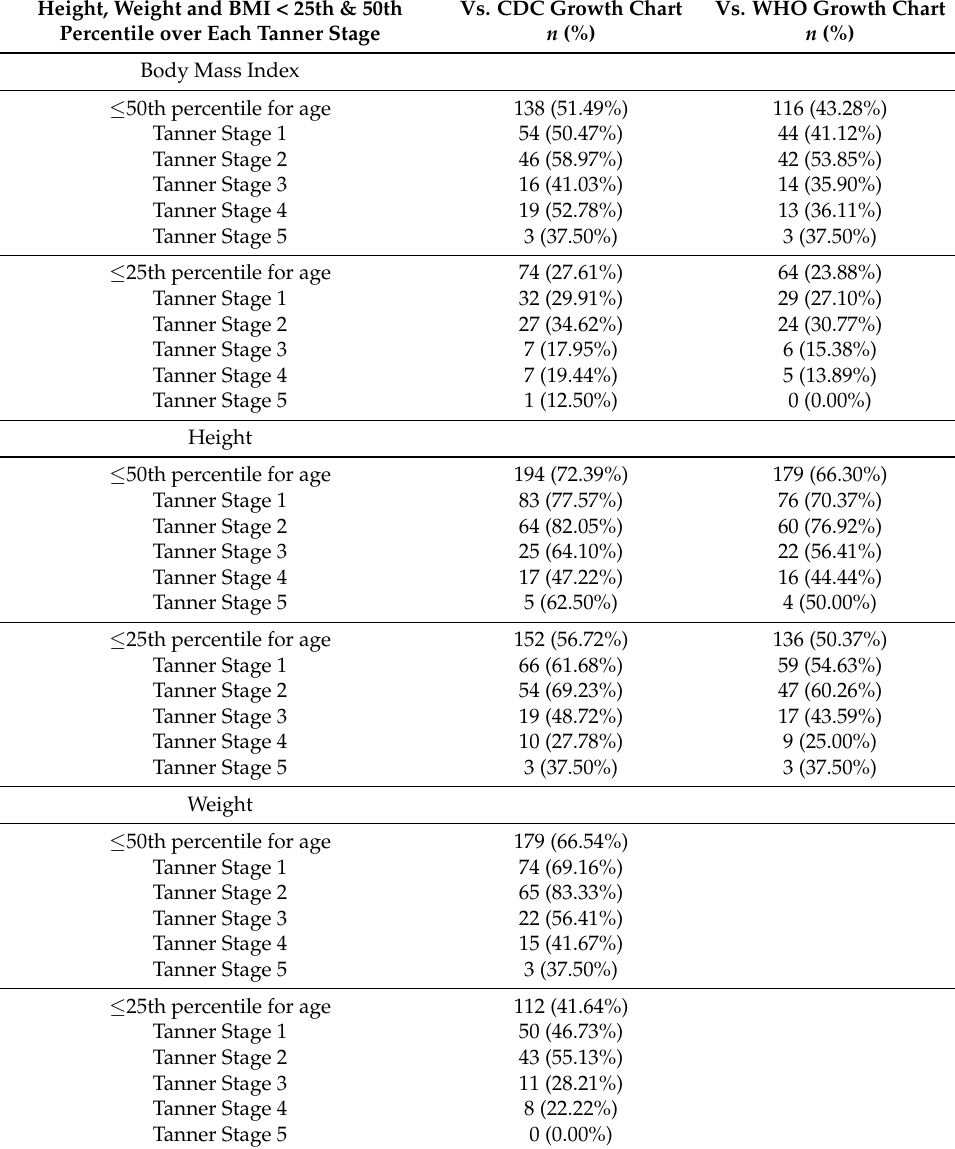
Table 4. Comparison of anthropometric measurements with CDC and WHO